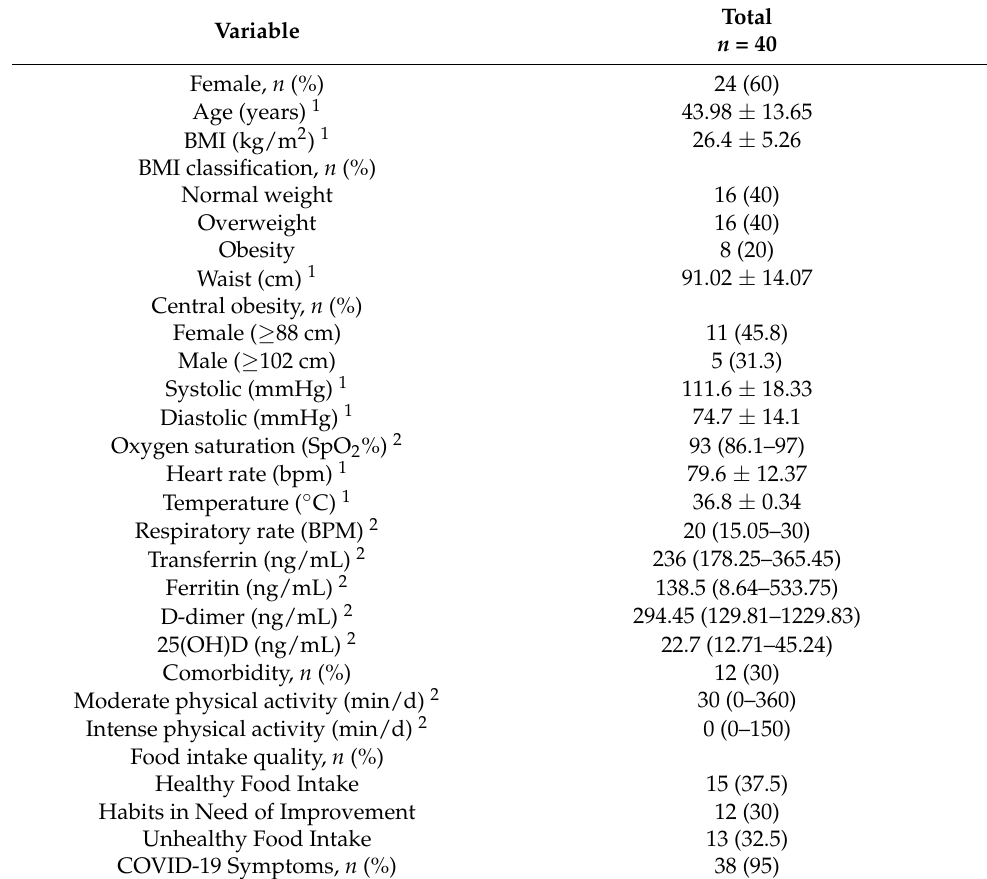
Table 1. Clinical features of SARS-CoV-2 positive